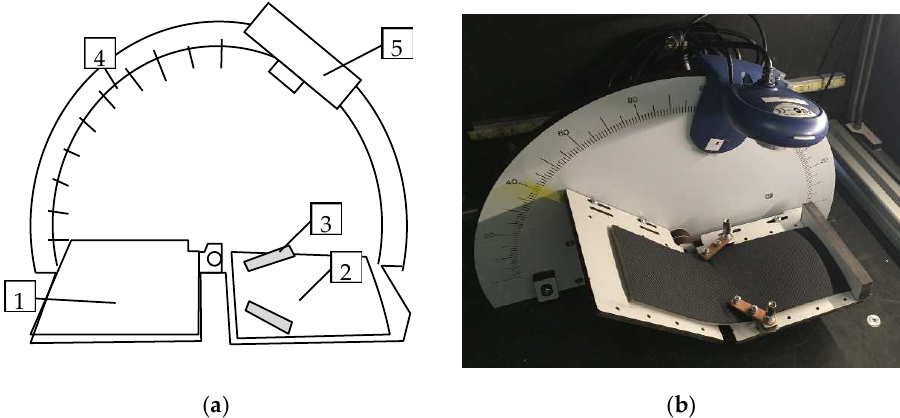
Figure 4. The innovated device called SAHF-W: ( a ) the scheme of device 1—rotating arm; 2—sta- tionary arm; 3—fixed clamps; 4—protractor scale; 5—camera; ( b ) photo of the produced device.